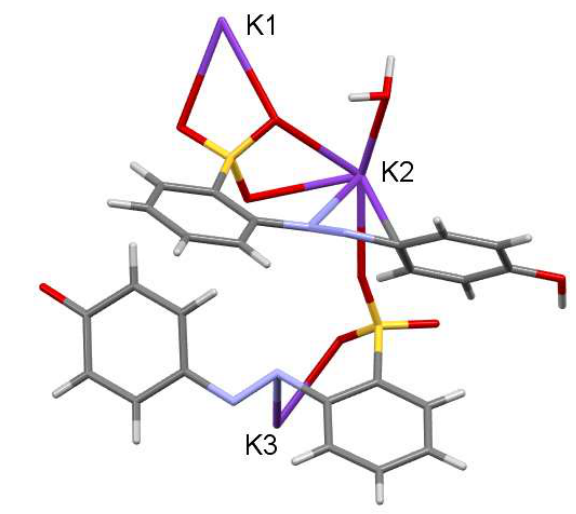
Figure 8. Part of the 2-dimensional coordination polymer structure of [Ba (17* )(OH 2 ) 5 ]. Propagation of the polymer is through Ba-O-Ba bridges parallel to the a direction and through head and tail bonding of the azo ligand parallel to the bc diagonal. H atoms are omitted for clarity. Green = Ba.